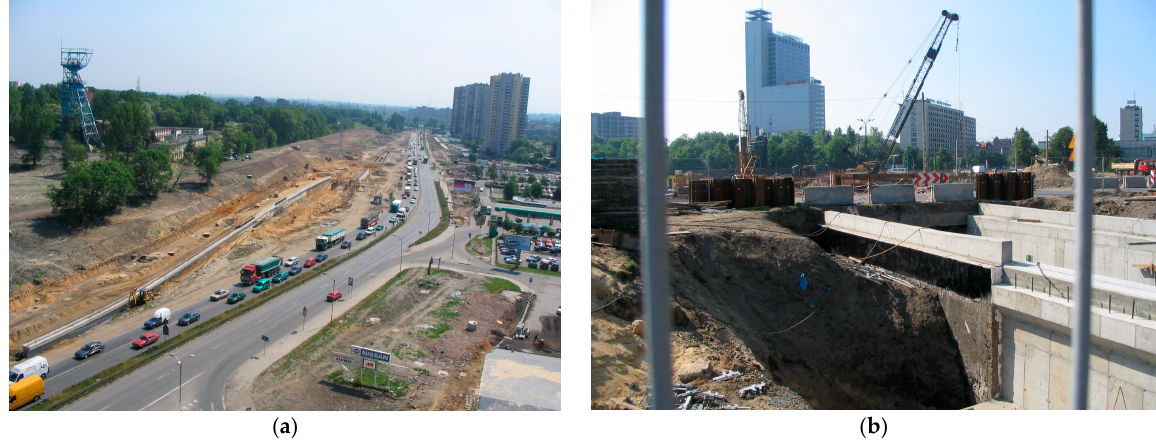
Figure 7. Execution of works as part of the construction of the tunnel under the Roundabout in Katowice: ( a ) beginning of the tunnel; ( b ) construction of diaphragm walls.